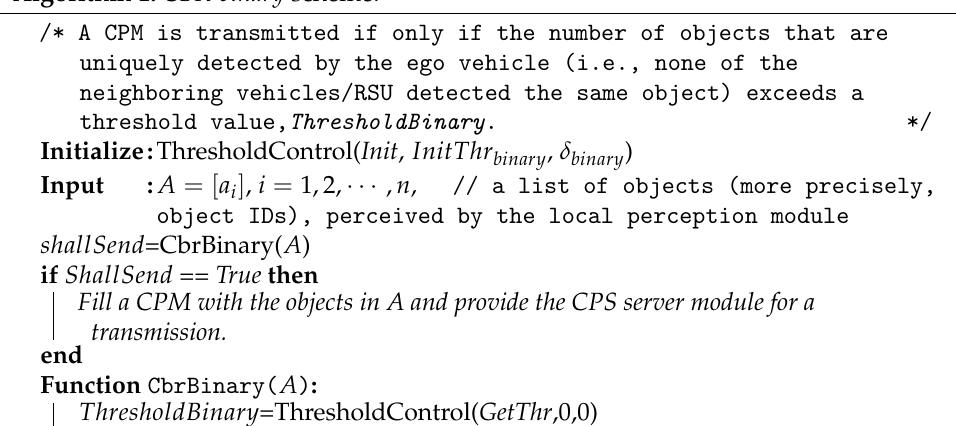
Algorithm 1: CBR-binary